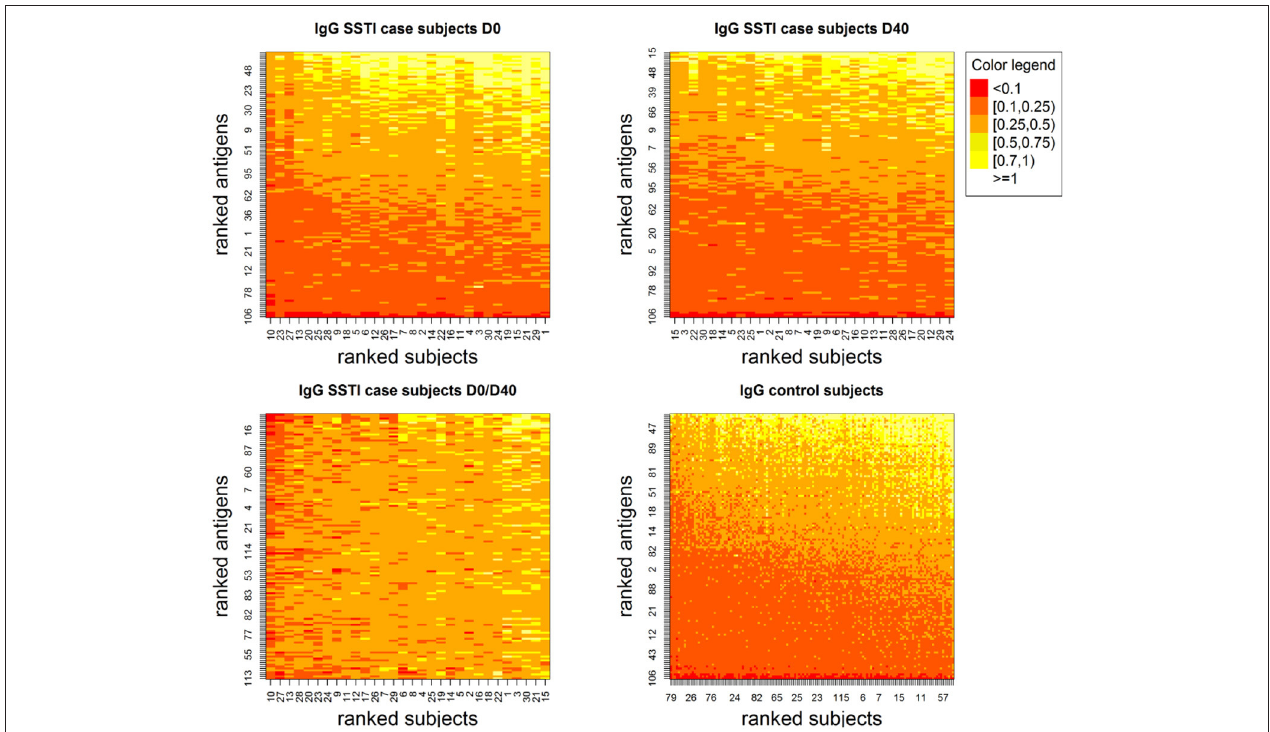
FIGURE 1 | Showing IgG levels (anti-human IgG mg/ml) for each antigen (y-axis) derived through the calibration process for the SSTI cases at the two measured time points ( Top ) and for the control subjects ( Bottom Right ). Low values are shown in darker tones and higher values are shown in progressively lighter tones. Although few antigens are consistently associated with very low IgG levels, antibodies were detectable against most S. aureus antigens. Also, among case subjects, temporal changes in IgG were observed both across subjects and antigens ( Bottom Left ).